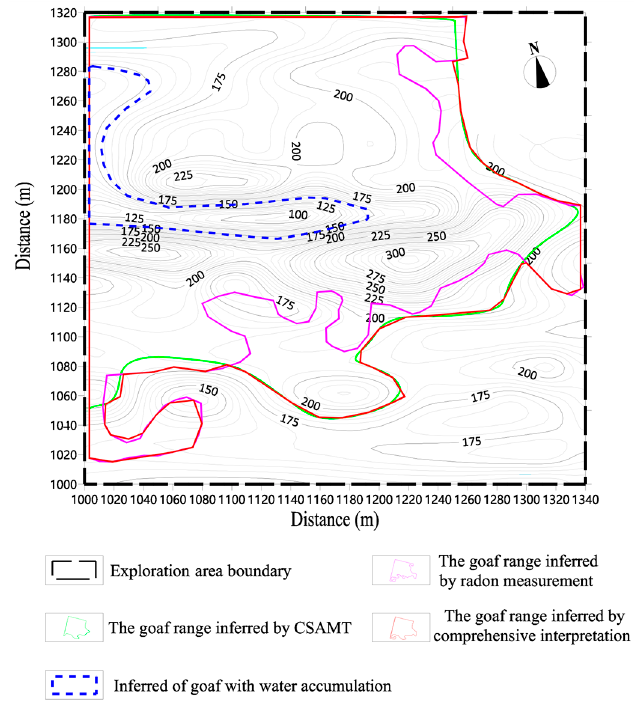
Figure 15. Comprehensive Interpretation of Goaf Result Map.